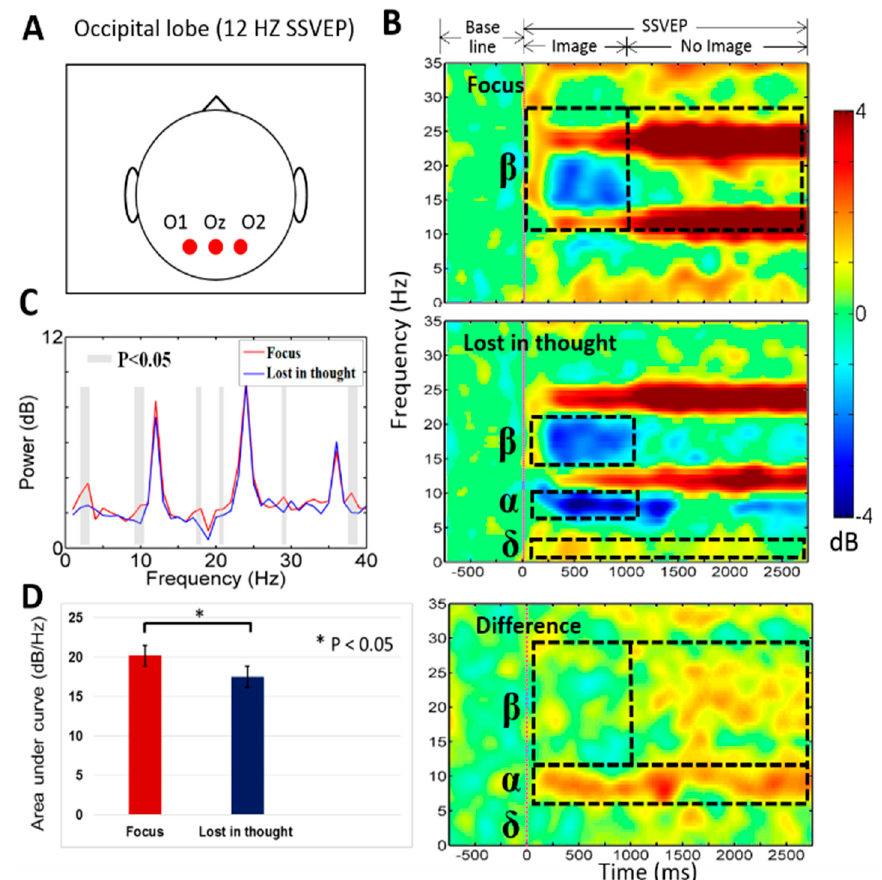
Figure 6. ( A ) Shows O1, Oz, O2 electrodes location in occipital lobe. ( B ) The ERSP was investigated during mental focus and lost-in-thought states at 12 Hz SSVEP. The pink vertical line display the stimulus onset. Statistically significant at p < 0.05. Color bar indicate the scale of significant ERSP in decibel (dB). ( C ) The PSD for the mental focus state (red line) and lost-in-thought state (blue line). The grey areas presents statistically pairwise significant difference (p < 0.05) in t-tests between the mental focus and lost-in-thought states. ( D ) The AUC was measured in mental focus and lost-in-thought states (*p < 0.05).